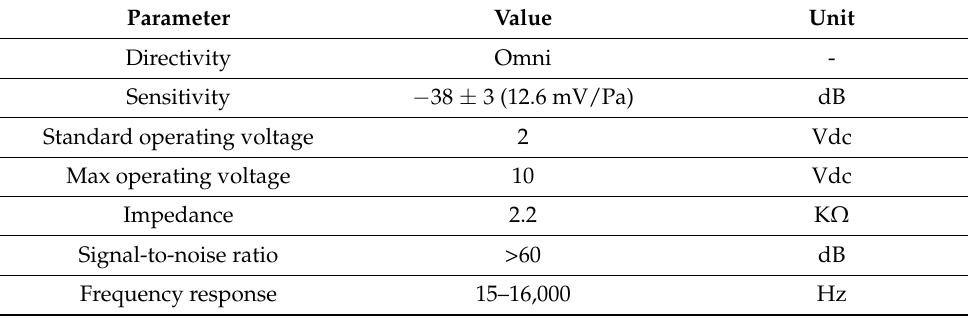
Figure 7. Used microphone frequency characteristic curve. Table 2. Microphone specifications.